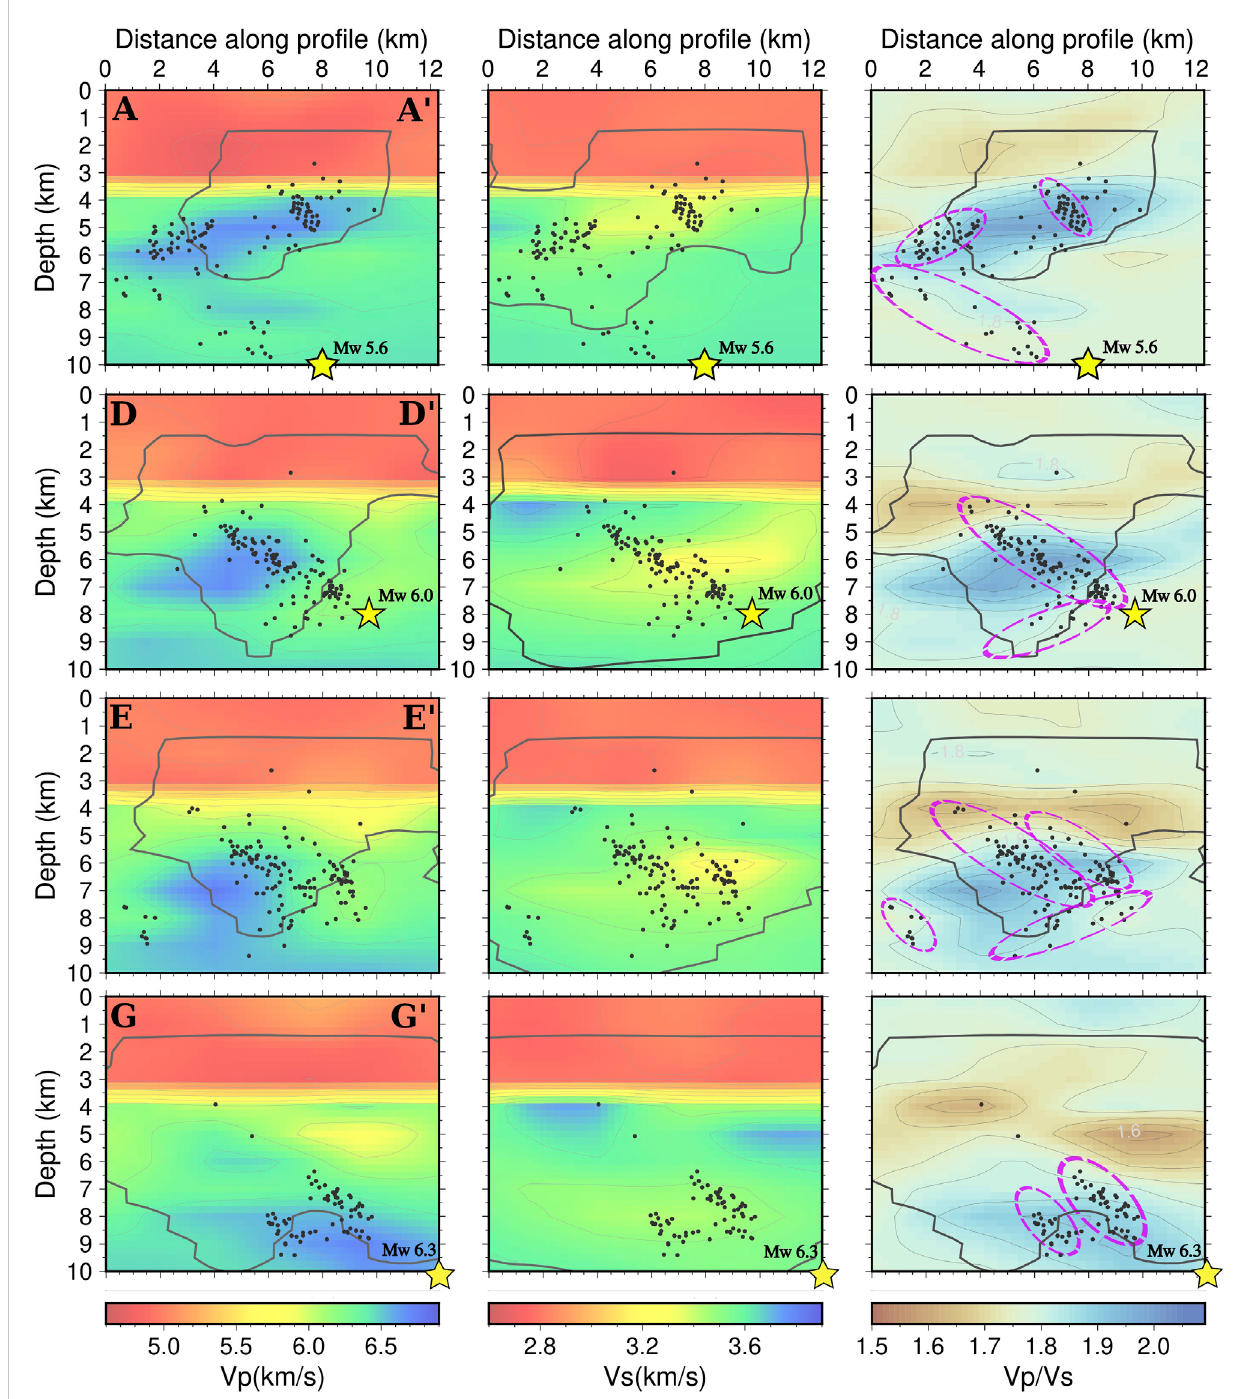
FIGURE 3 V P , V S and V P /V S model and micro-earthquake locations projected onto the AA ’ , DD ’ , EE ’ and GG ’ cross-sections located in Figure 1. Well-resolved areas are contoured by solid dark gray lines. The purple dashed ellipses represent the cluster of seismicity found in this work. Yellow stars represent the mainshocks of the